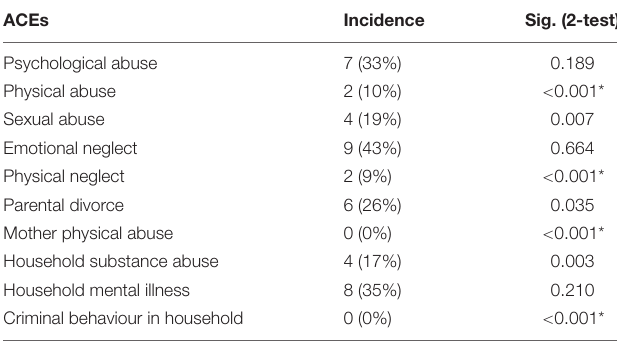
TABLE 6 | Types of adverse childhood experiences